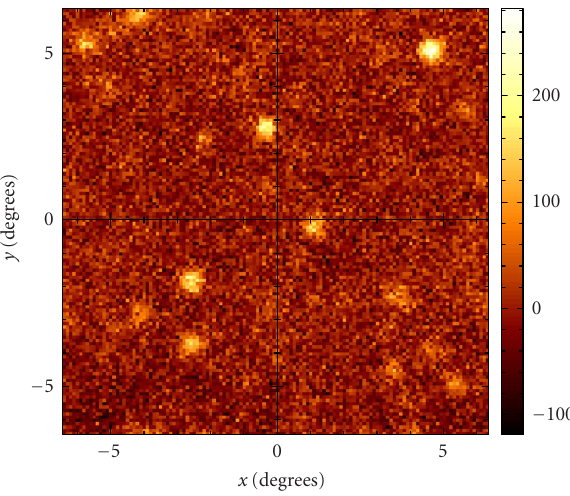
Figure 1: Residual map of a 12 . 8 × 12 . 8 square degrees sky patch at 30 GHz after the application of a maximum entropy compo- nent separation. The residual map is obtained by subtracting from the 30 GHz map the di ff erent components (CMB and foregrounds) given by the maximum entropy algorithm. Bright point sources ap- pear as spots in the images whereas faint point sources are masked by the residual